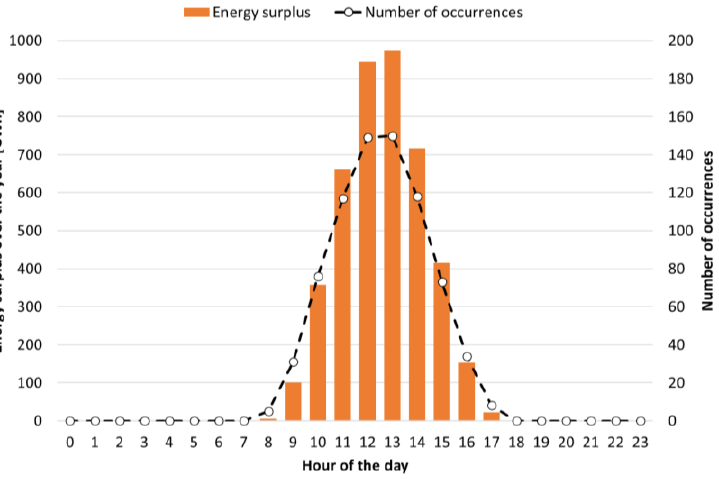
Figure 15. Distribution of hourly energy surplus over the year and number of occurrences in Case 1.